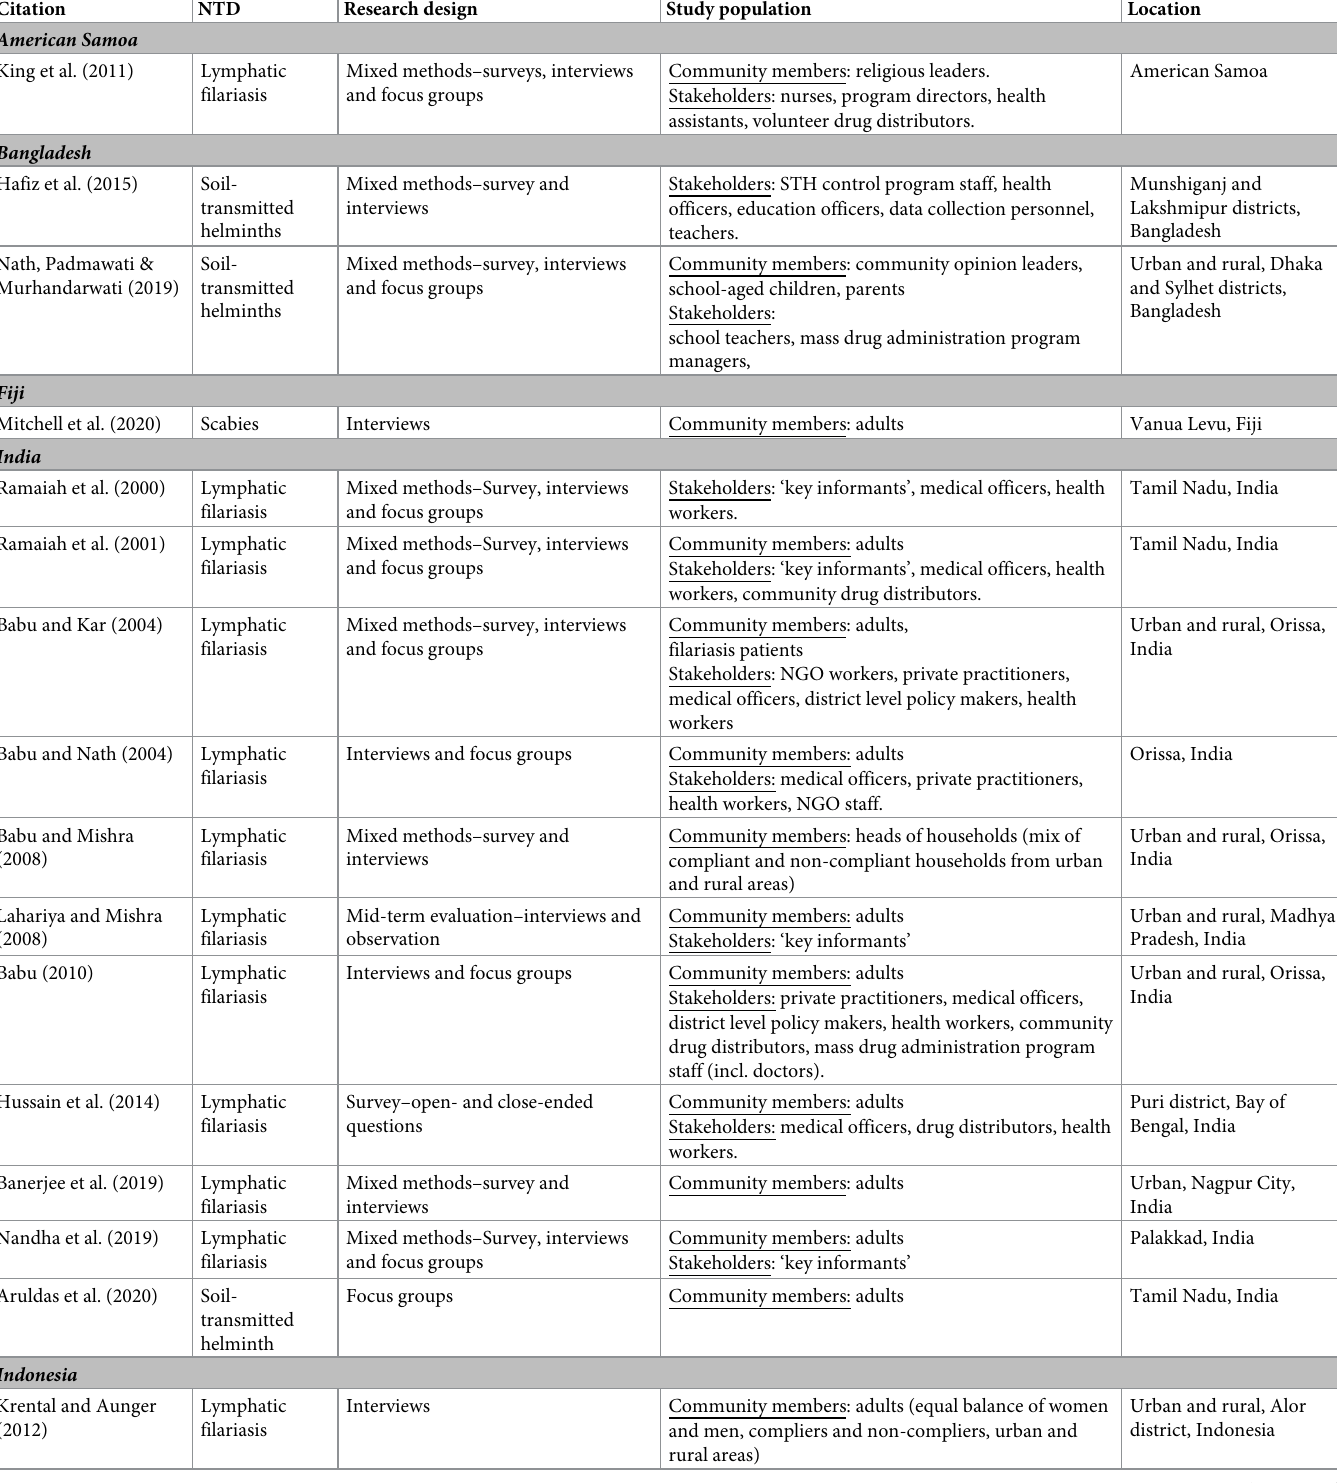
Table 2. Summary of paper